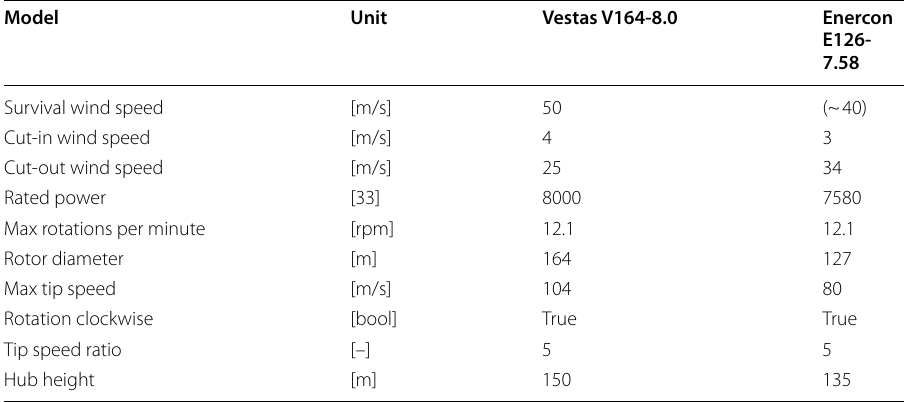
Table 1 Two wind turbine models used in the case study (wind-turbine-models: Vestas V164-8.0 2022; wind-turbine-models: Enercon 2022)